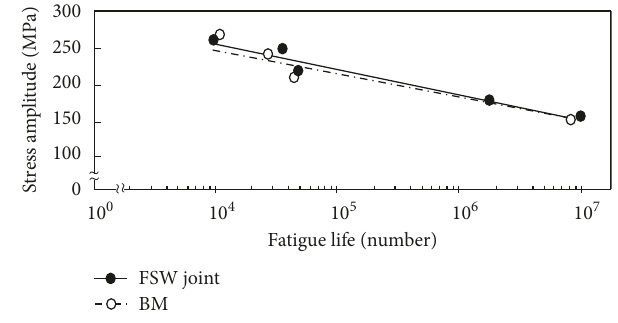
Figure 10: Stress-number curves of the BM and FSW joints ob- tained by fatigue